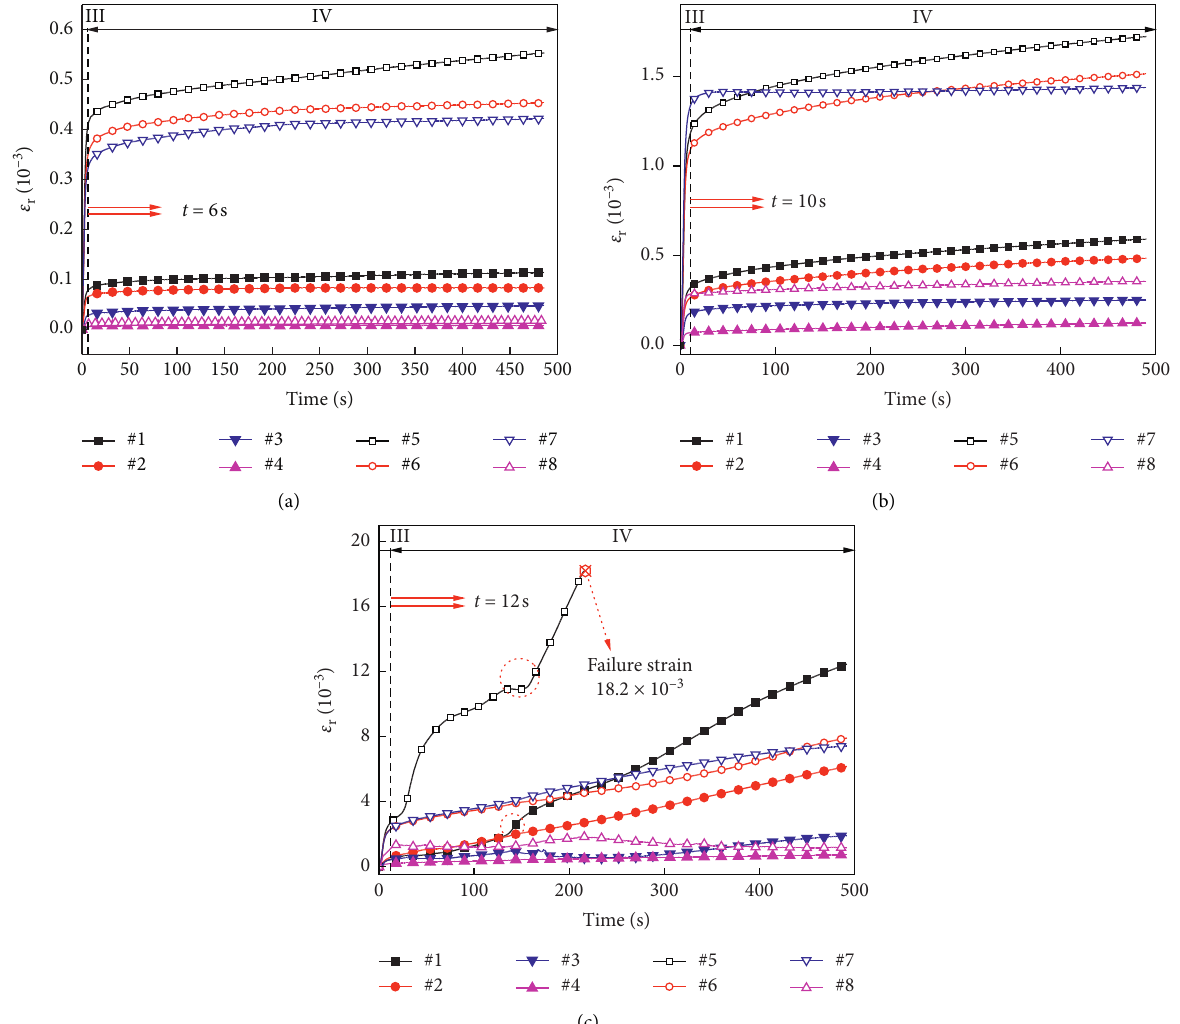
Figure 6: Radial deformation during unloading stage and maintaining after unloading. The unloading stage of different initial confining stress ((a) 10, (b) 20, and (c) 30MPa) lasted for 6s, 10s, and 12s, respectively. The maintaining stage of which lasted for